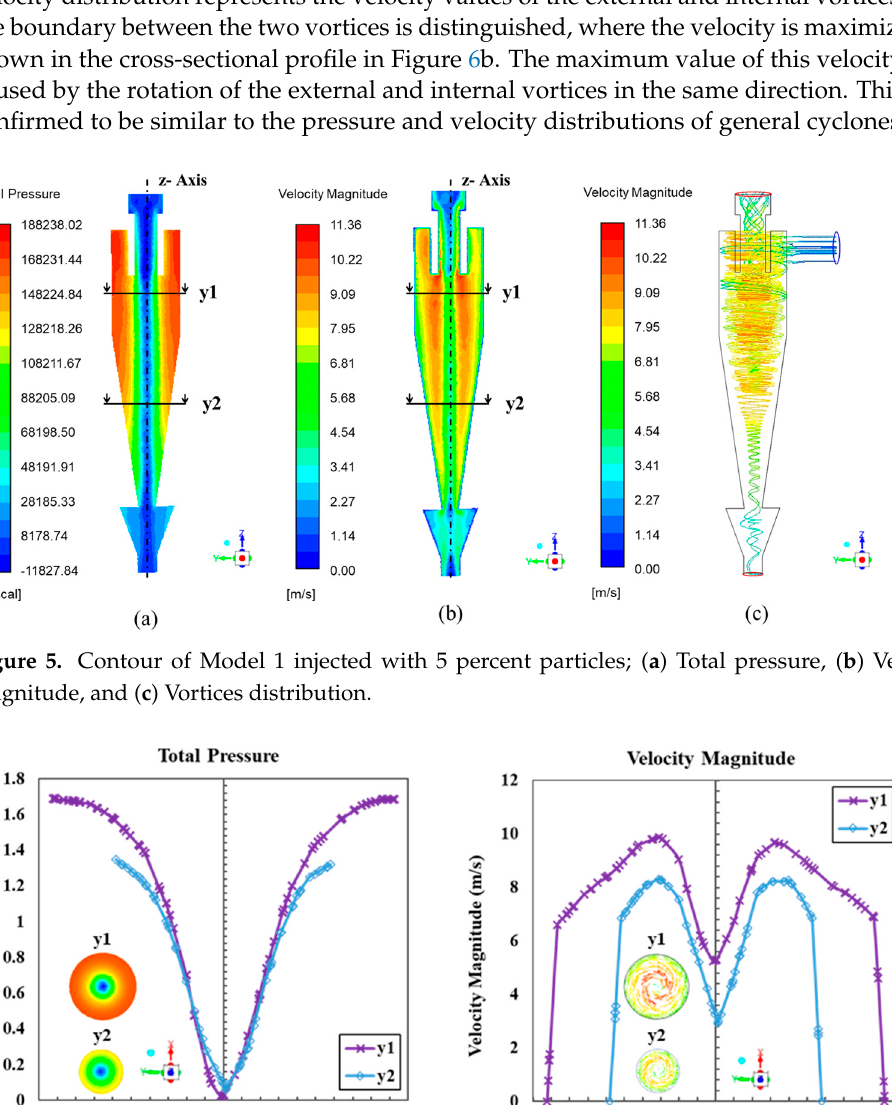
Figure 4. Experimental setup.